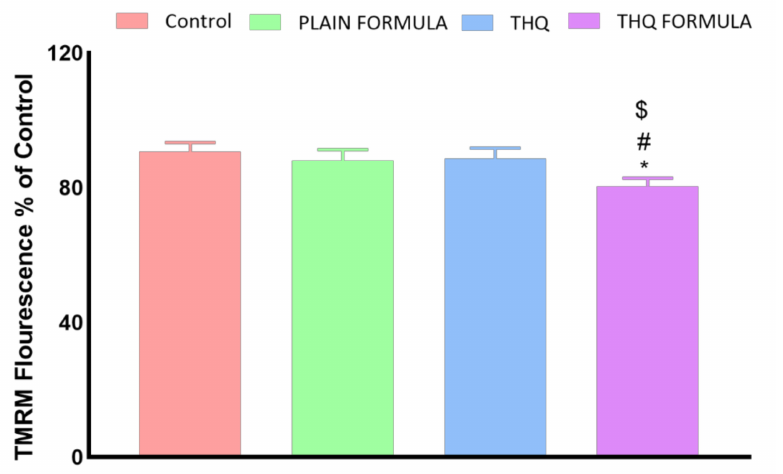
Figure 8. Effect of the THQ formula on mitochondrial membrane potential (MMP) in A549 cells. Data presented in bar charts are mean ± SD ( n = 3). *, #, or $: Statistically different from control, plain formula, or THQ, respectively at p <